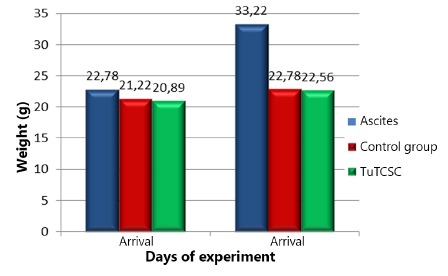
Weight on arrival and reoperation in all three groups